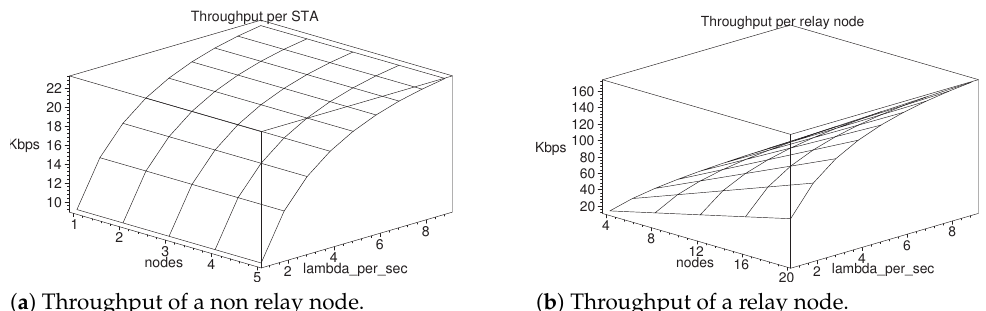
Figure 5. Per node